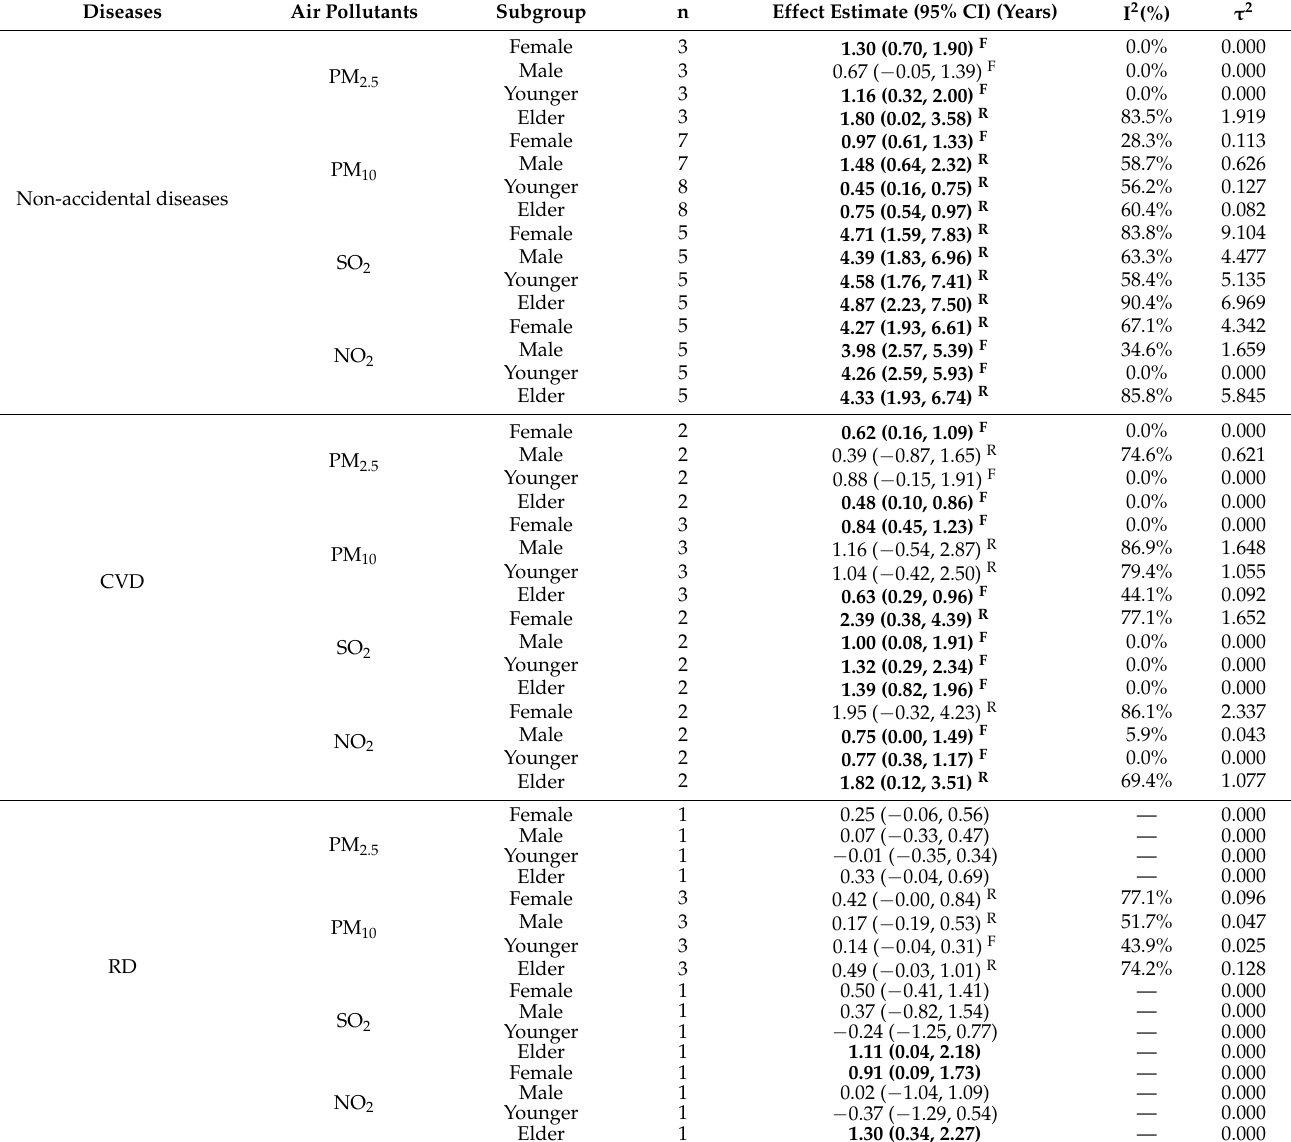
Table 2. Meta-analysis results for the association of YLL for non-accidental diseases, cardiovascular disease (CVD) and respiratory disease (RD) with ambient air pollution stratified by gender and age in